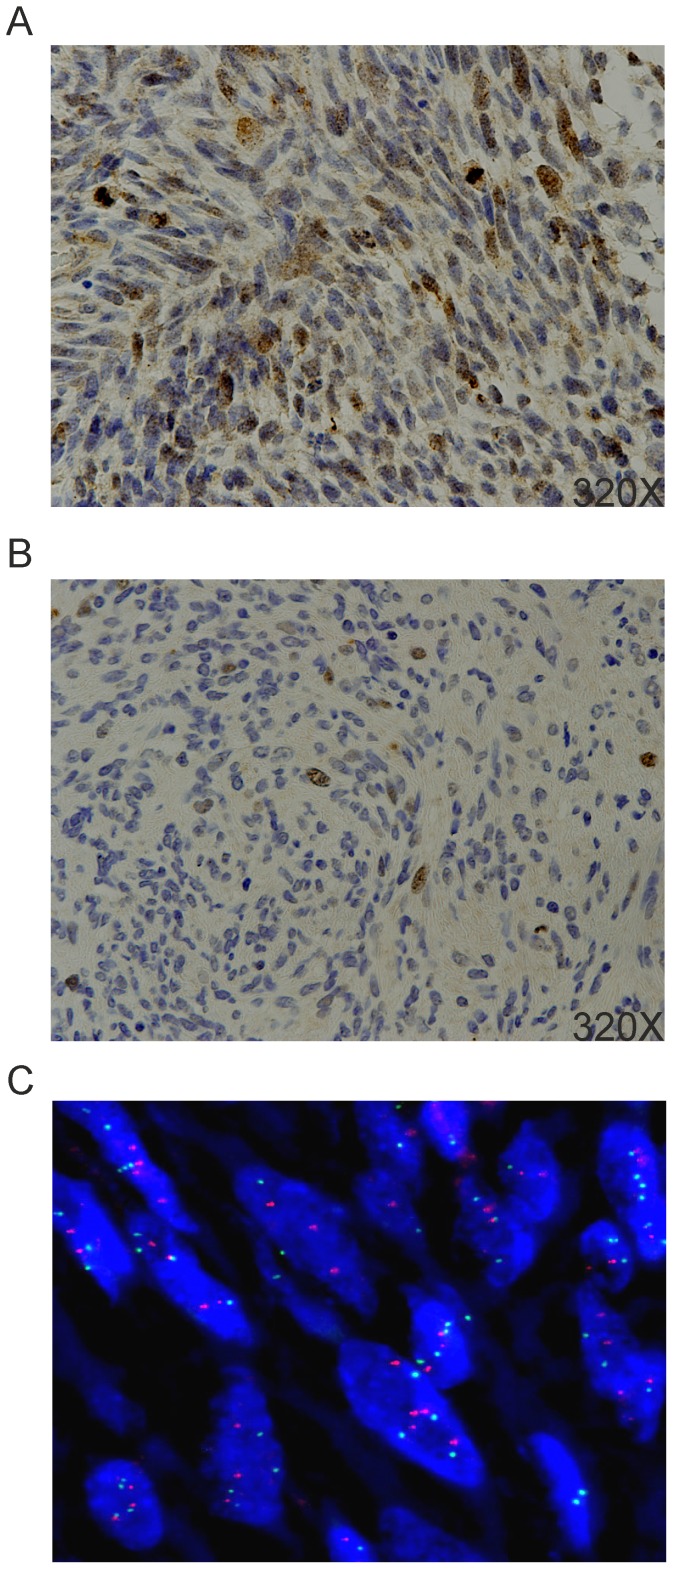
Survivin immunostaining and FISH analysis.IHC showing (A) a high positivity specimen (≥40%) with diffuse cells stained in the nucleus, and (B) a low positivity sample (<40%) with scattered neoplastic cells showing nuclear staining. (C) FISH analysis in a case of BIRC5 copy number gain (red and green spots correspond to probes for BIRC5 and CEP17, respectively; original magnification 100×).